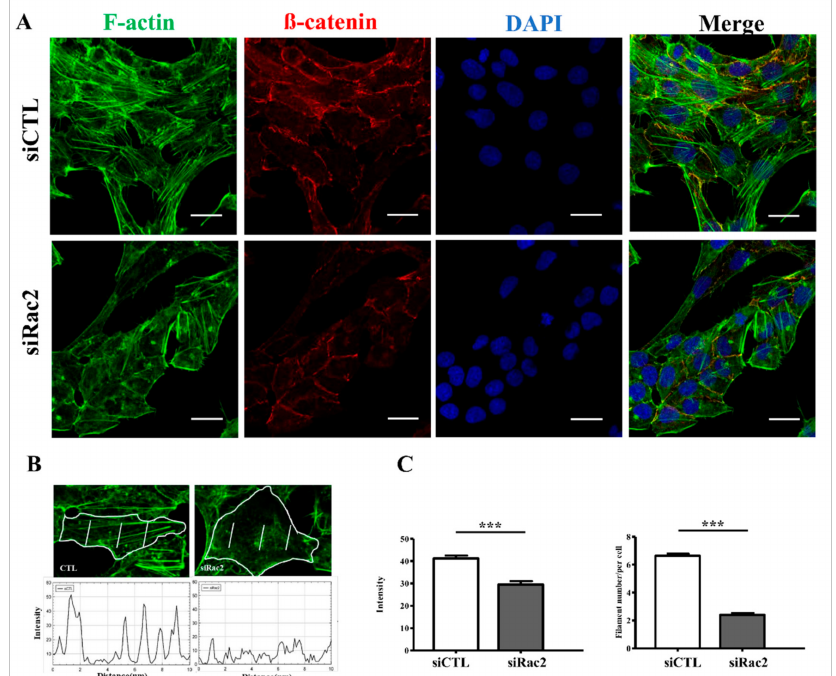
Figure 8. The expression of actin filament in terms of intensity and number of actin filaments in the rat ventricular cardiomyocytes with and without silencing Rac2 gene by confocal immunofluorescence study. ( A ) Silencing Rac2 gene to suppress Rac2 expression significantly changed the actin distribution in the rat ventricular cardiomyocytes. ß-catenin staining for cell membrane; DAPI staining for nuclei. ( B ) Three 10- µ m lines were drawn at equal distance at three separate parts of cardiomyocyte and the mean immunofluorescence intensity and number of immunofluorescence peaks were calculated by using ImageJ (spot function) and these values were measured from 100 individual cells per sample in each of the four repeated experiments. ( C ) The intensity of actin (F-actin) and number of actin myofilaments per cardiomyocyte were significantly decreased by Rac2 siRNA. Scale bar = 20 µ m. ***: p <